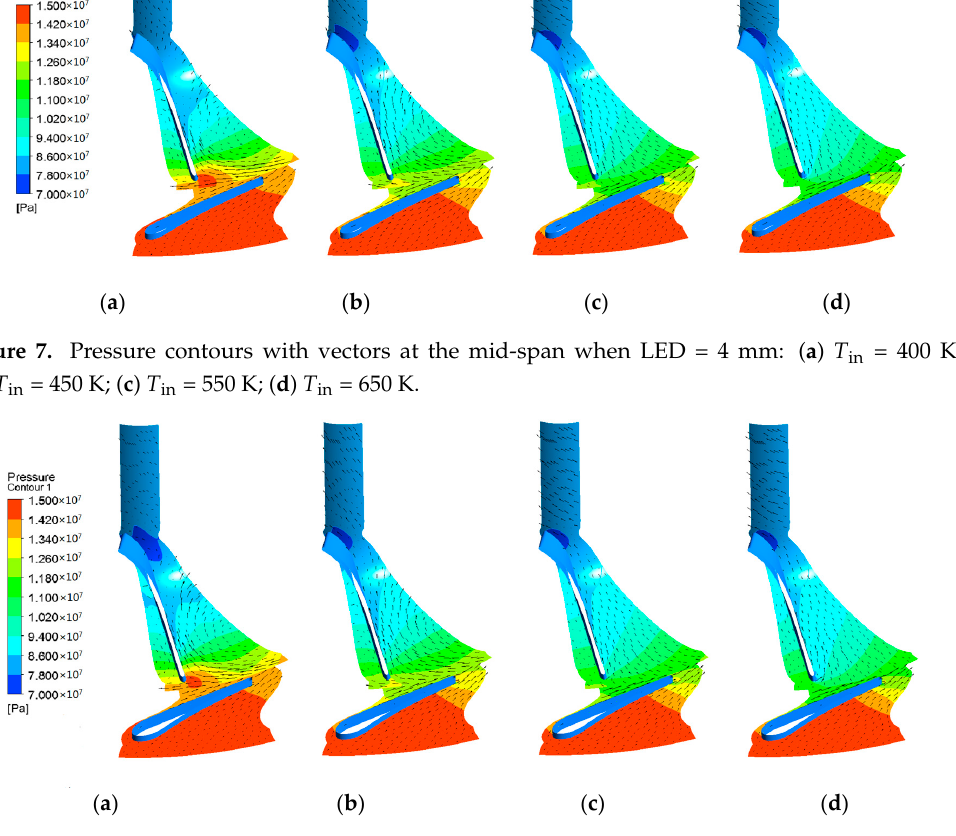
Figure 8. Pressure contours with vectors at the mid-span when LED = 7 mm: ( a ) T in = 400 K; ( b ) T in = 450 K; ( c ) T in = 550 K; ( d ) T in = 650K.